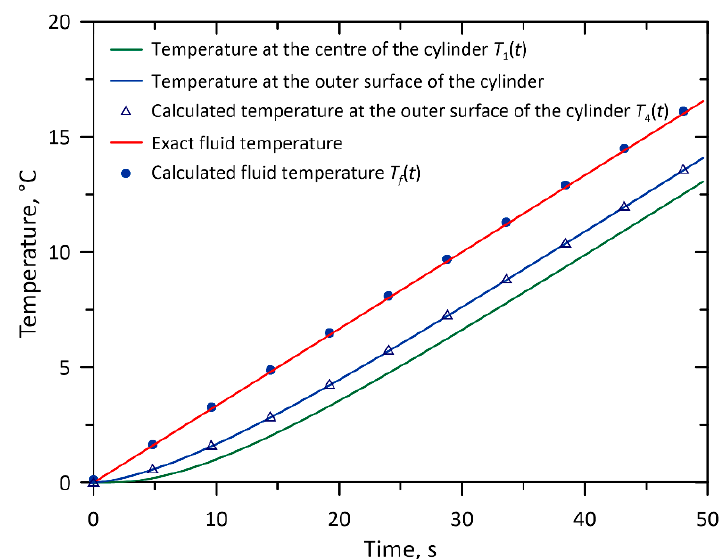
Figure 2. Fluid temperature and temperature “measured” at the axis of the 15 mm diameter thermometer and on its outer surface—comparison of the input fluid temperature with the results obtained from the solution of the inverse problem for the stepwise increase in fluid temperature.